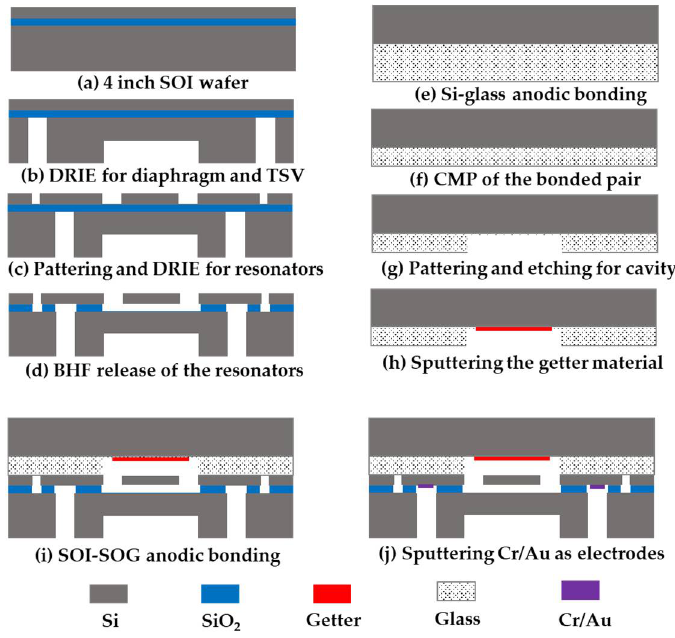
Figure 4. Fabrication process of the proposed resonant pressure micro sensor: ( a – d ) Fabrication of the SOI wafer; ( e – h ) Fabrication of the SOG cap; ( i ) SOI-SOG anodic bonding; ( j ) Fabrication of